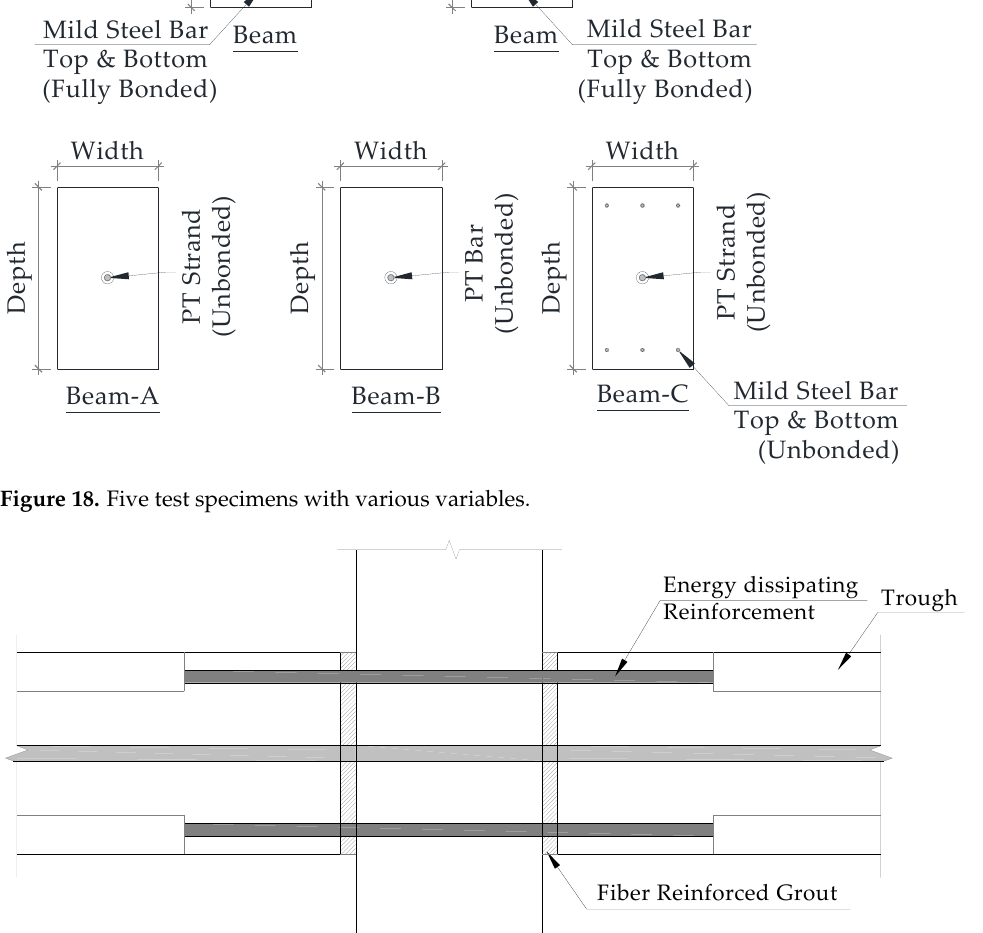
Figure 19. Precast beam column assembly.